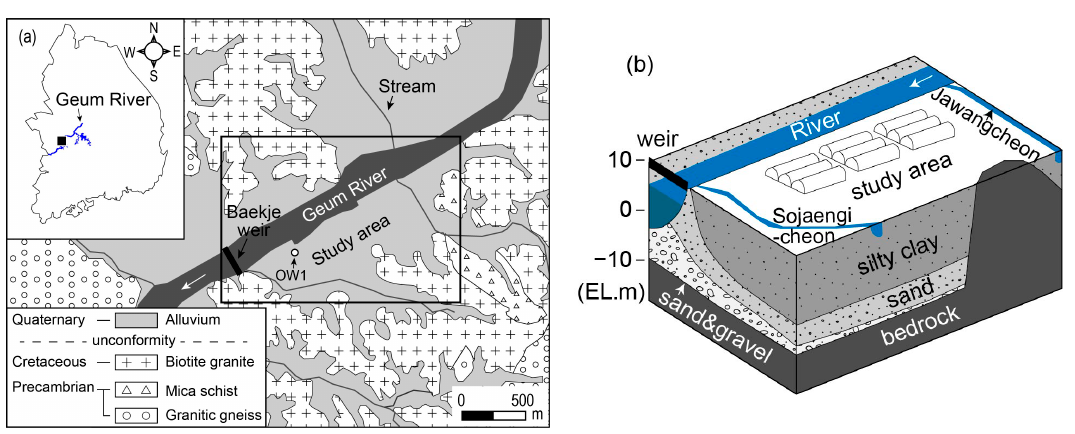
Figure 1. ( a ) Location and geological map of the study region in the Geum River Basin, South Korea (modified from [30]); ( b ) Characteristics of the alluvial successions.